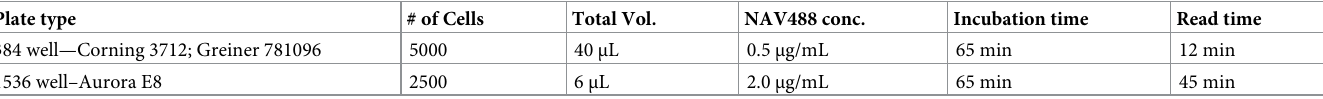
Table 2. Optimized LSC assay parameters. Plate type # of